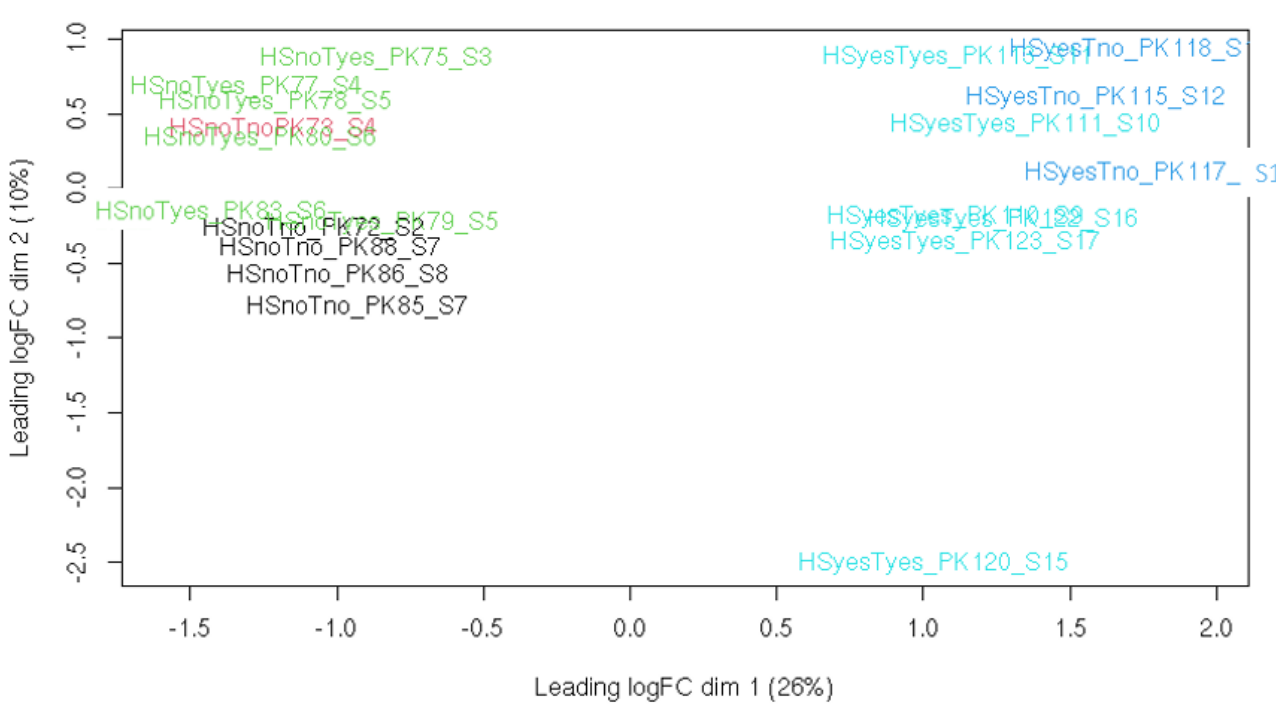
Figure 1. Principal component analysis plot for all libraries including specimen 120. Treatment groups are color − coded.